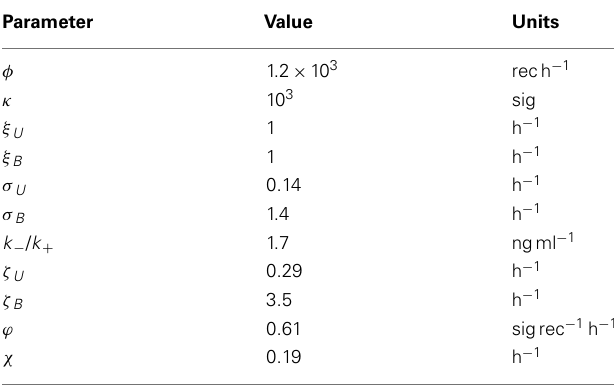
TableA1 | Parameter estimates obtained from the mean field model of IL-7 receptor dynamics